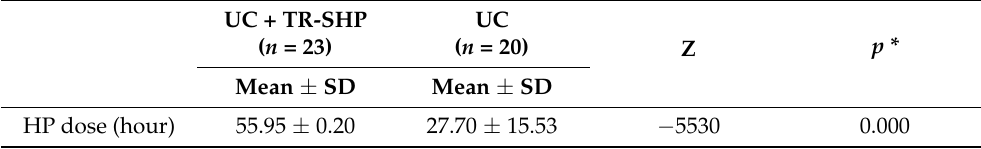
Table 6. Home program implementation dose comparison of